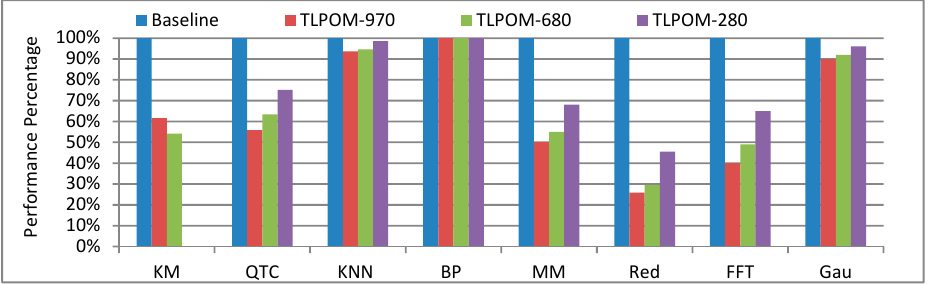
Figure 11. Algorithms’ performance with different GPUs.